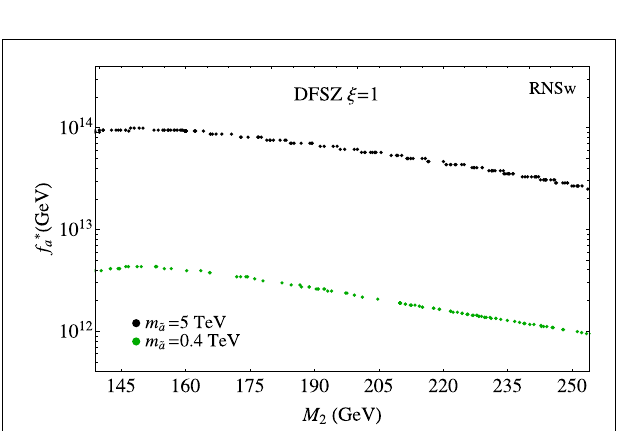
indicate the range of f a where θ i > 3 which might be considered unnatural. We also show the f a range which is expected to be probed by the ADMX experiment in the next few